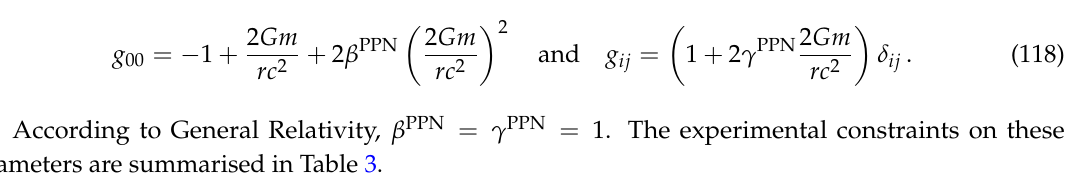
Table 3. Some constraints on parameterised post-Newtonian (PPN) parameters from recent tests.